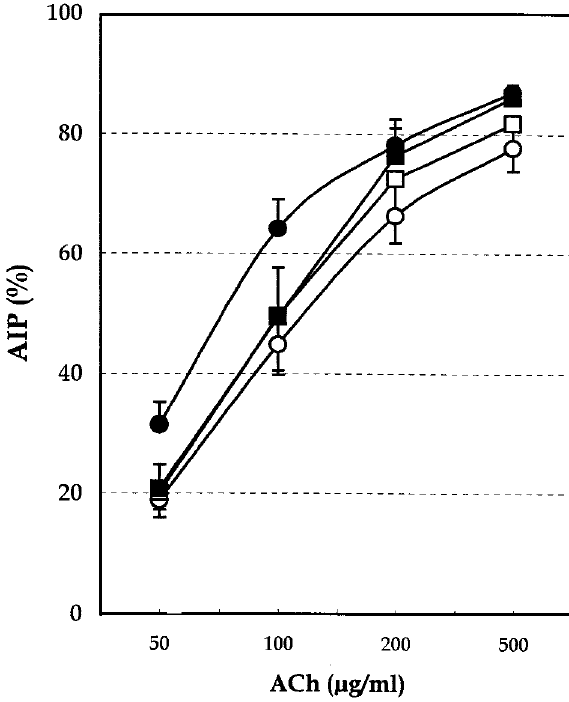
FIG. 2. Influence of Ro 20± 1724 (10mg/kg) on cumulative dose± response curve for acetylcholine (50, 100, 200 and 500 m g/ml) in anaesthetized guinea-pigs, 24h after ovalbu- min challenge (OA). Sensitized guinea-pigs were treated orally with Ro 20± 1724 (10mg/kg), 24 and 3h before the antigen challenge (OA) or saline exposure (SAL). Symbols represent control with ( h ) or without ( s ) Ro 20± 1724 and after antigen challenge with ( j ) or without ( d ) Ro 20± 1724 ( n =4± 20). No significant difference is noted between OA and OA+Ro 20± 1724. Significant difference between SAL+Ro 20± 1724 and Ro 20± 1724+OA is P